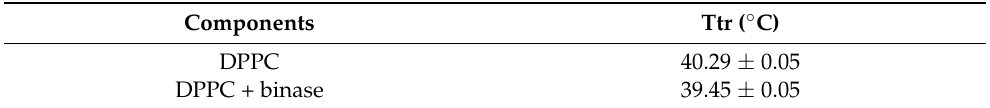
Table 1. Half-transition temperature (Ttr) of turbidity in lipid suspensions.